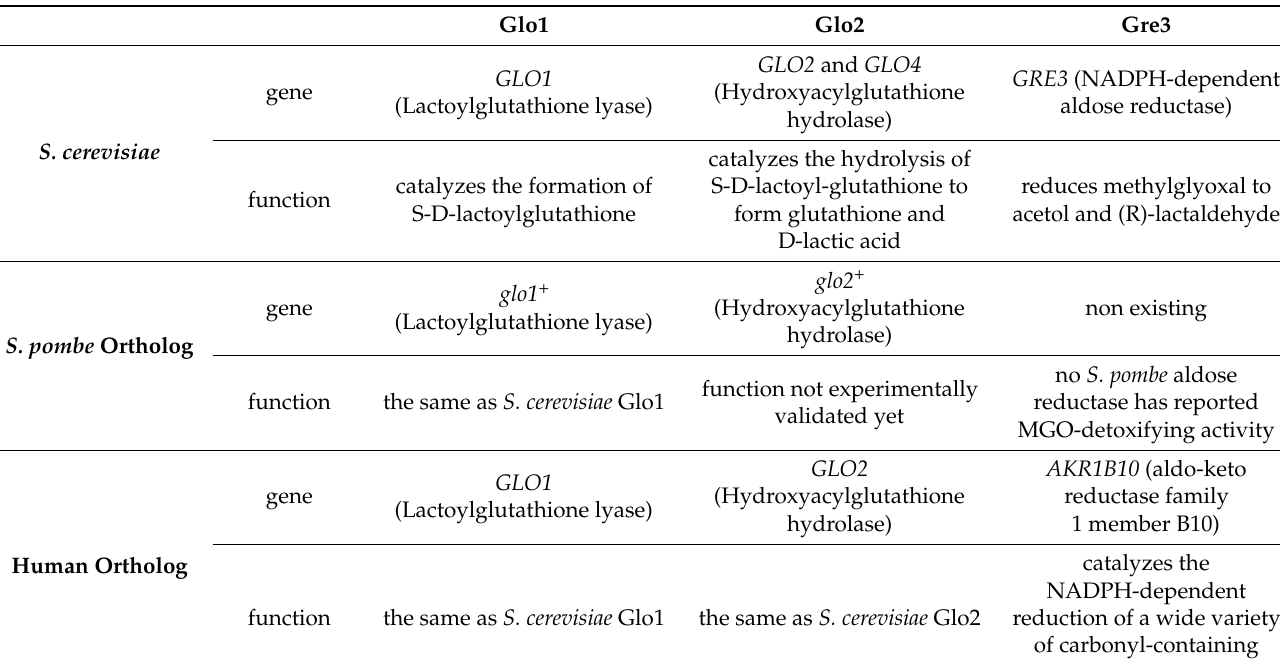
Table 1. Overview of the functions of Glo1, Glo2, and Gre3 in Saccharomyces cerevisiae and the corresponding orthologs in Schizosaccharomyces pombe and